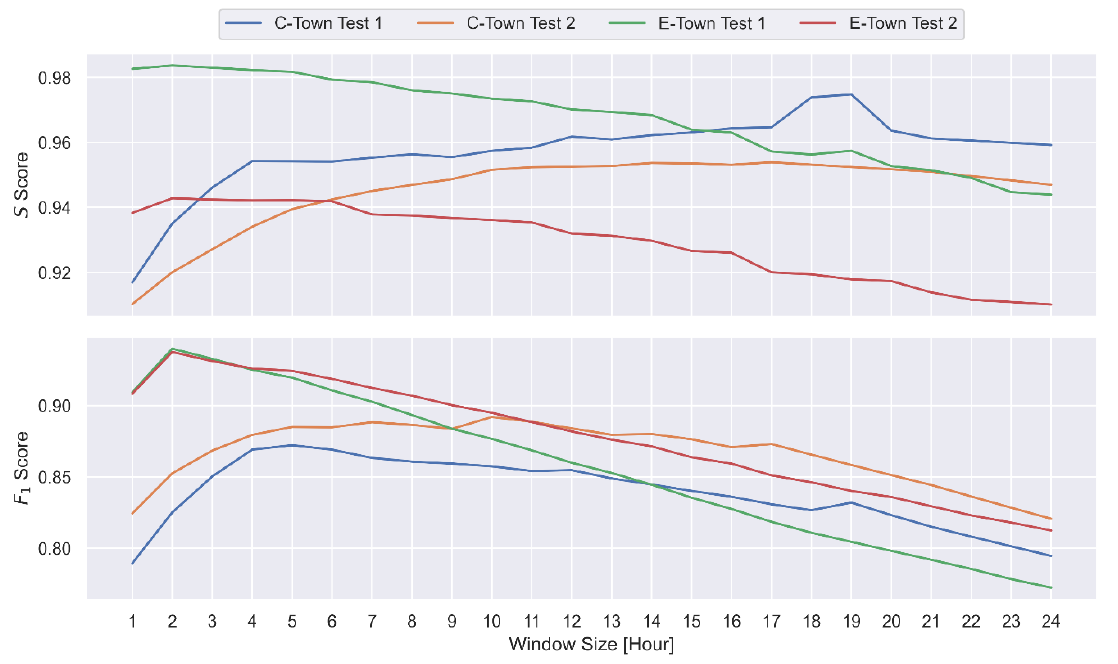
Figure A2. SSDS performance over different window sizes in the smoothing rolling window.